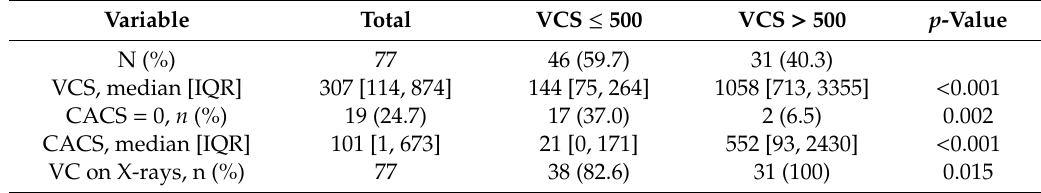
Table 2. CACS and the presence of VC on X-rays in the two VCS groups.